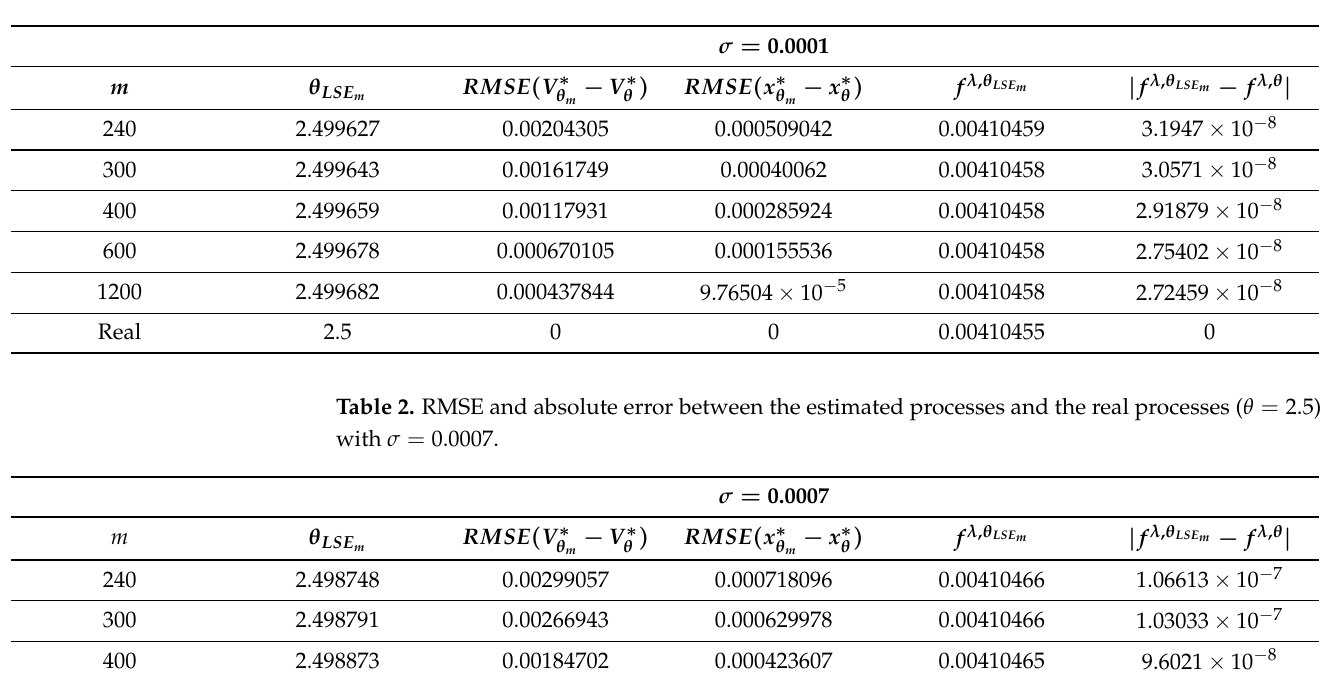
Table 1. RMSE and absolute error between the estimated processes and the real processes ( θ = 2.5) with σ = 0.0001.